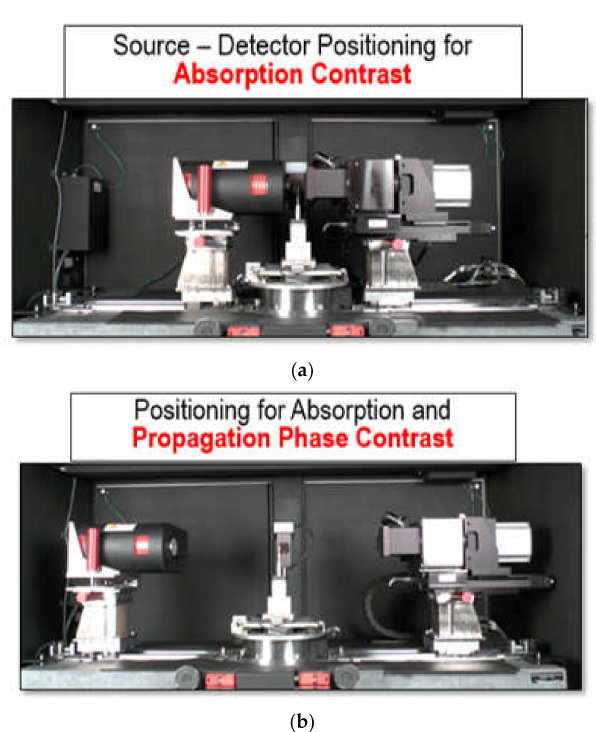
Figure 6. Source–detector positioning for ( a ) absorption contrast; ( b ) phase propagation